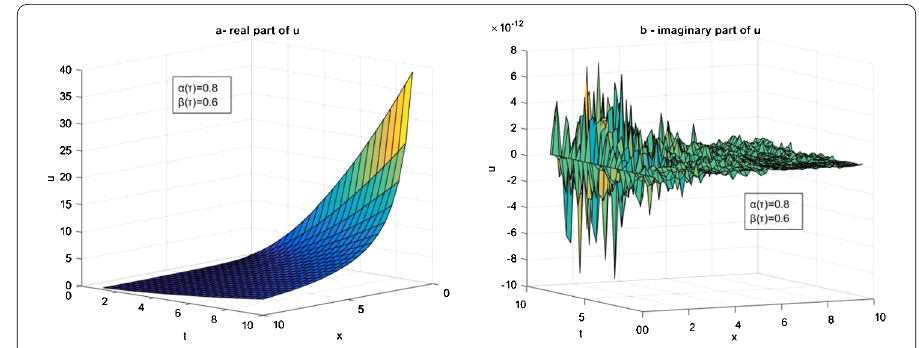
Figure 7 The graph of the solution u in Example 4, where α ( τ ) = 0.8 and β ( τ ) = 0.6. The graph ( a ) is the real part, and the graph ( b ) is the imaginary part of